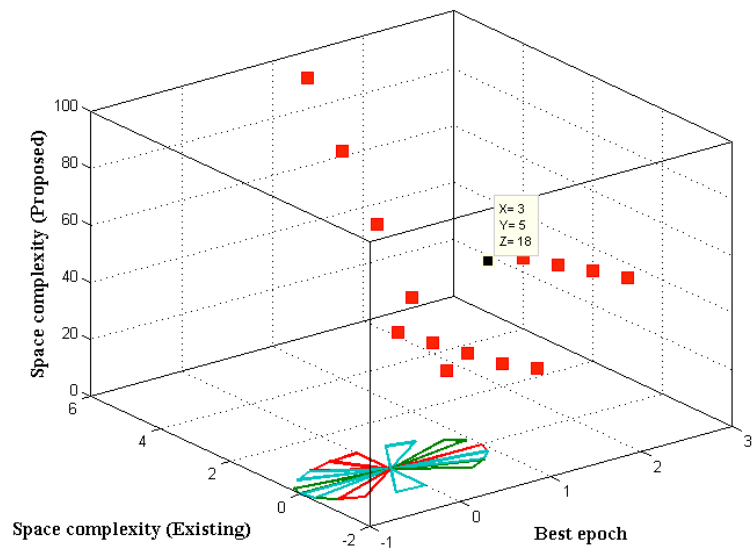
Figure 8. Comparison of space complexities.